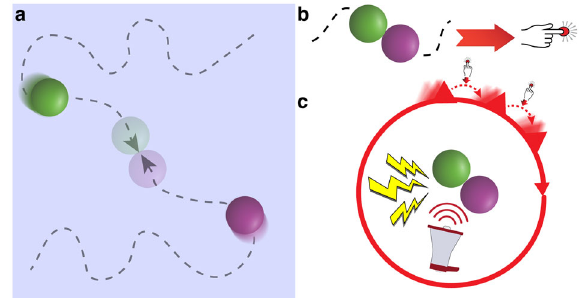
Fig. 1 Moving-circles paradigm and controllability. Paradigm schematic of a single trial with controllability where a shows a schematic representation of the display. When circles collided, a mild shock plug aversive sound was administered. For controllable participants, a button press moved the virtual wheel by 1/12 of the circle ( b and c ). The participant had to press the button multiple times to terminate the stressor. For uncontrollable participants, the virtual wheel moved the same number of times as that of the yoked participant. Uncontrollable participants were asked to press the button every time the wheel moved; the button press moved the virtual wheel a random amount (not shown). Stressor duration was matched between the two